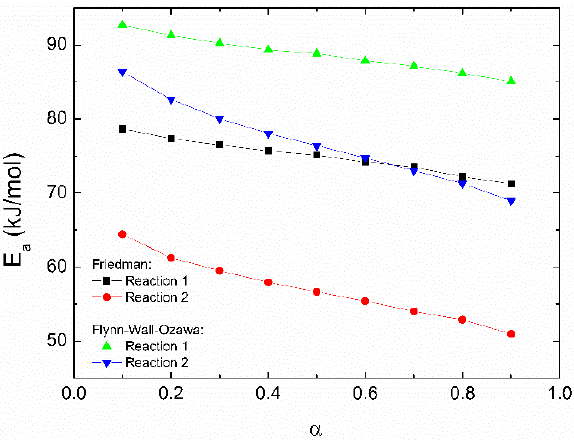
Figure 7. Apparent activation energy for the reactions 1 and 2 as a function of the conversion degree, from the Flynn–Wall–Ozawa and Friedman methods. Lines provide a visual guide. from the Flynn–Wall–Ozawa and Friedman methods. Lines provide a visual